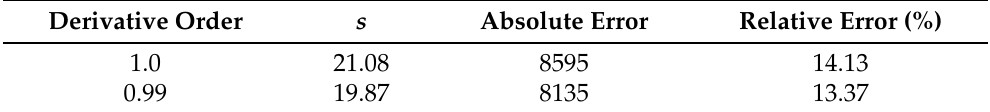
Table 2. Results of model fitting.